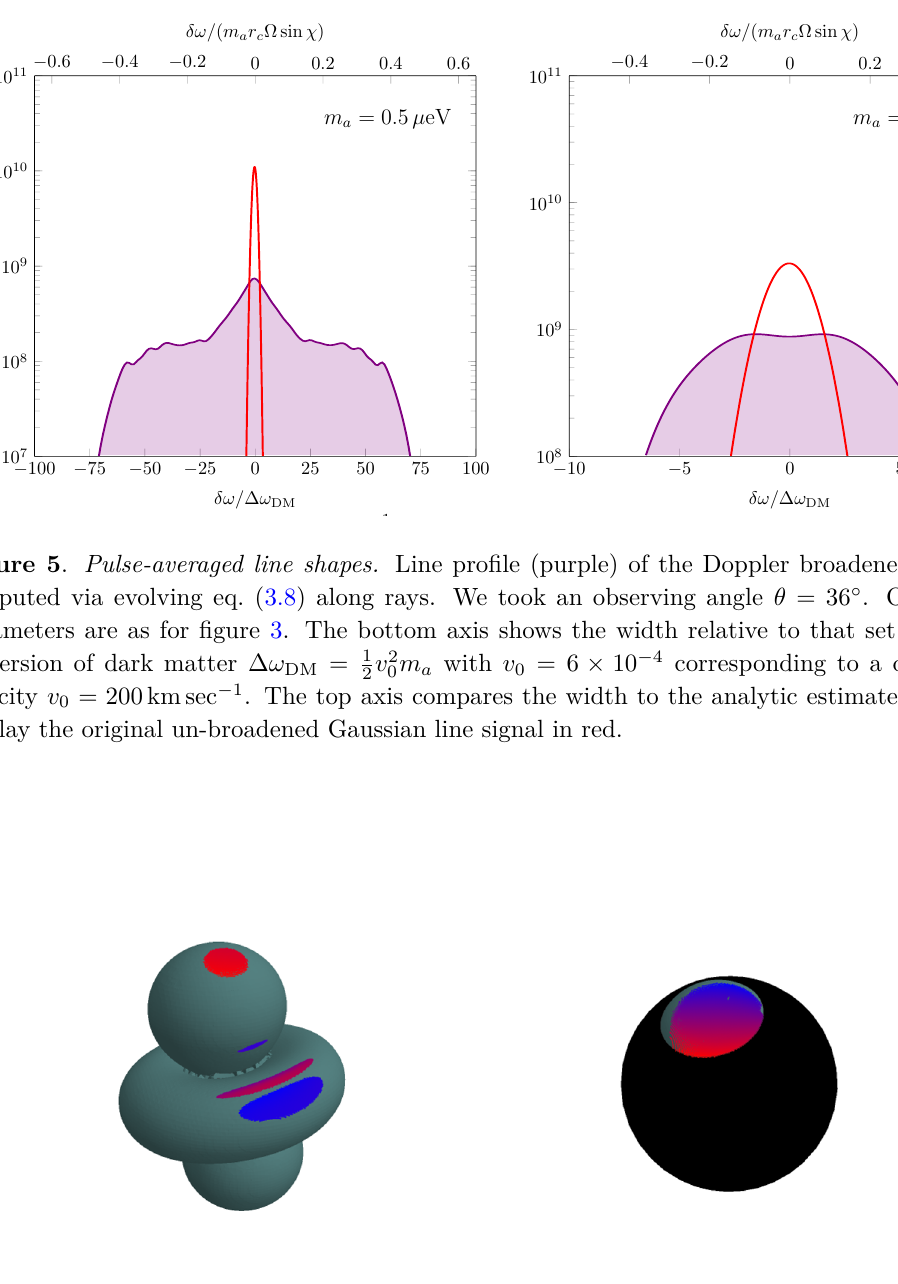
Figure 6 . Doppler shift back-projected onto surface emission points. Projection of the redshifted/blue-shifted photons onto their emission points on the three-dimensional critical sur- face (gray) corresponding to the model parameters chosen in figure 4. The left and right panels correspond to m a = 0 . 5 µ eV and m a = 12 . 5 µ eV, respectively. For the higher mass, the critical surface only extends in the small polar cap regions above the stellar surface, which we illustrated with a black sphere. Note the two images are not to the same scale with respect to one